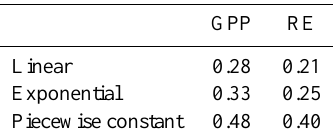
Table 3. R 2 values for different models relating ecosystem fluxes to total annual rainfall amounts (all three models contain the same number of parameters, so these values are directly comparable be- tween